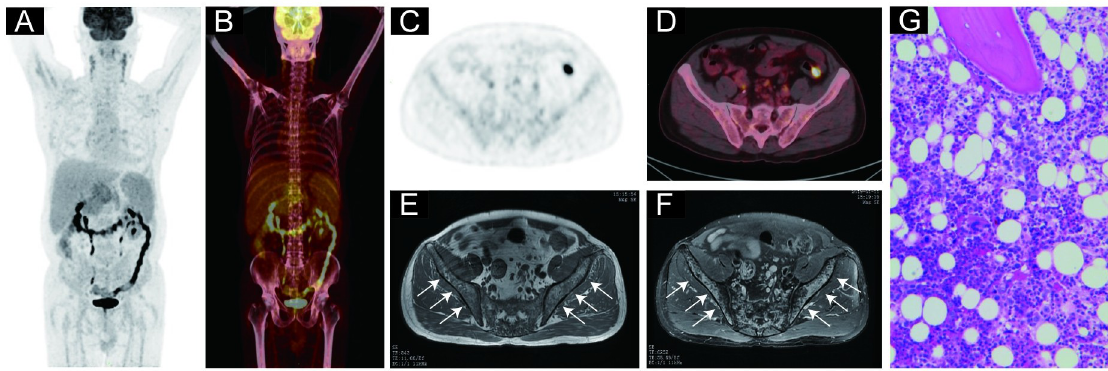
Fig 4. Representative case of a 55-year-old male diagnosed with diffuse large B-cell lymphoma. (A) and (B): Coronal positron emission tomography (PET) and PET-computed tomography (CT) images, respectively, revealing no lesions with increased focal 18 F-fluorodeoxyglucose (FDG) uptake (higher than that in the liver) in any bone marrow throughout the patient’s body. (C) and (D): Transverse PET and PET/CT images, respectively, revealing no lesions with increased focal FDG uptake in the right and left ilium. (E): The right and left ilium exhibiting multiple areas of low signal intensity on the T1-weighted, transverse pelvic magnetic resonance image (MRI). (F): The right and left ilium exhibiting multiple areas of high signal intensity on the fat-suppressed, T2-weighted, transverse pelvic MRI. (G): Hematoxylin and eosin staining confirmed bone marrow involvement in this patient. The patient’s blood glucose level before the PET/CT imaging was 7.7 mmol/L. https://doi.org/10.1371/journal.pone.0252226.g004 combines the metabolic information obtained using PET with the superior soft-tissue resolu- tion obtained using MRI. Previous studies have demonstrated that simultaneous PET/MRI is clinically feasible in patients with lymphoma [30, 31]. PET/MRI performance was demon- strated to be comparable to that of PET/CT for lesion detection and measurements of